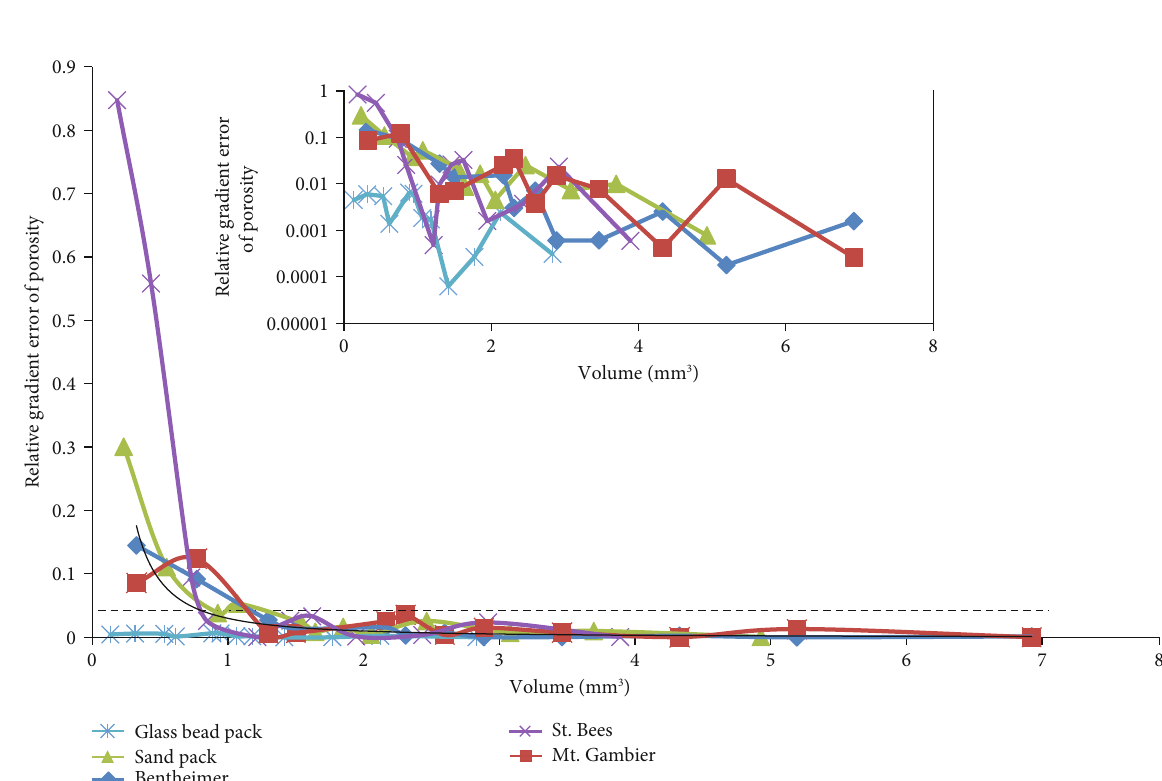
Figure 8: Relative gradient error of the fi ve samples plotted versus sample volume. The dashed black line is the 0.05 threshold